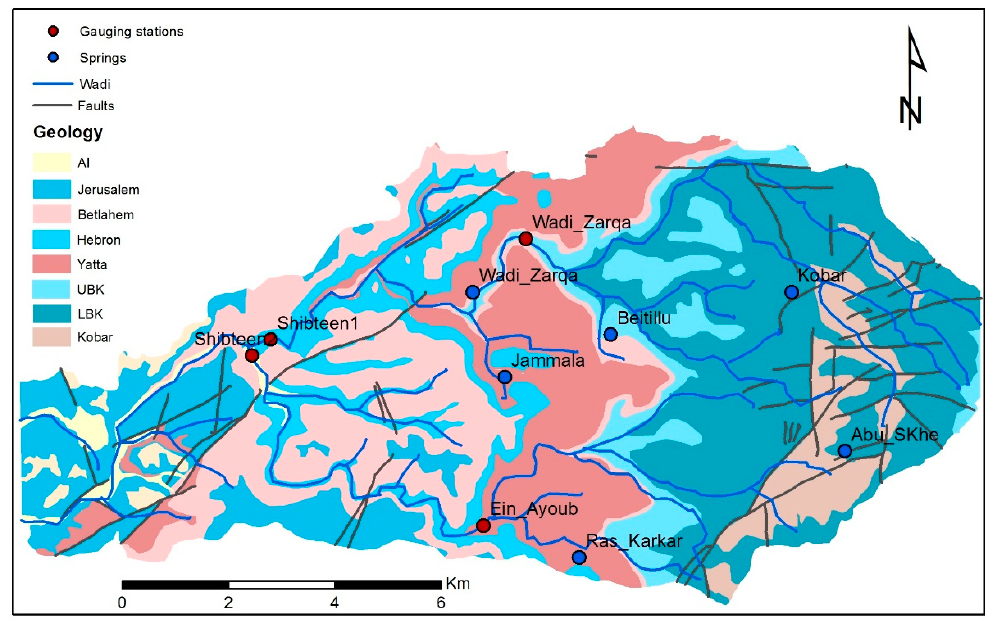
Figure 2. Summary geological map together with the locations of the main spring groups. Table 1. Lithostratigraphy of the Upper and Lower aquifers in the Wadi Natuf catchment